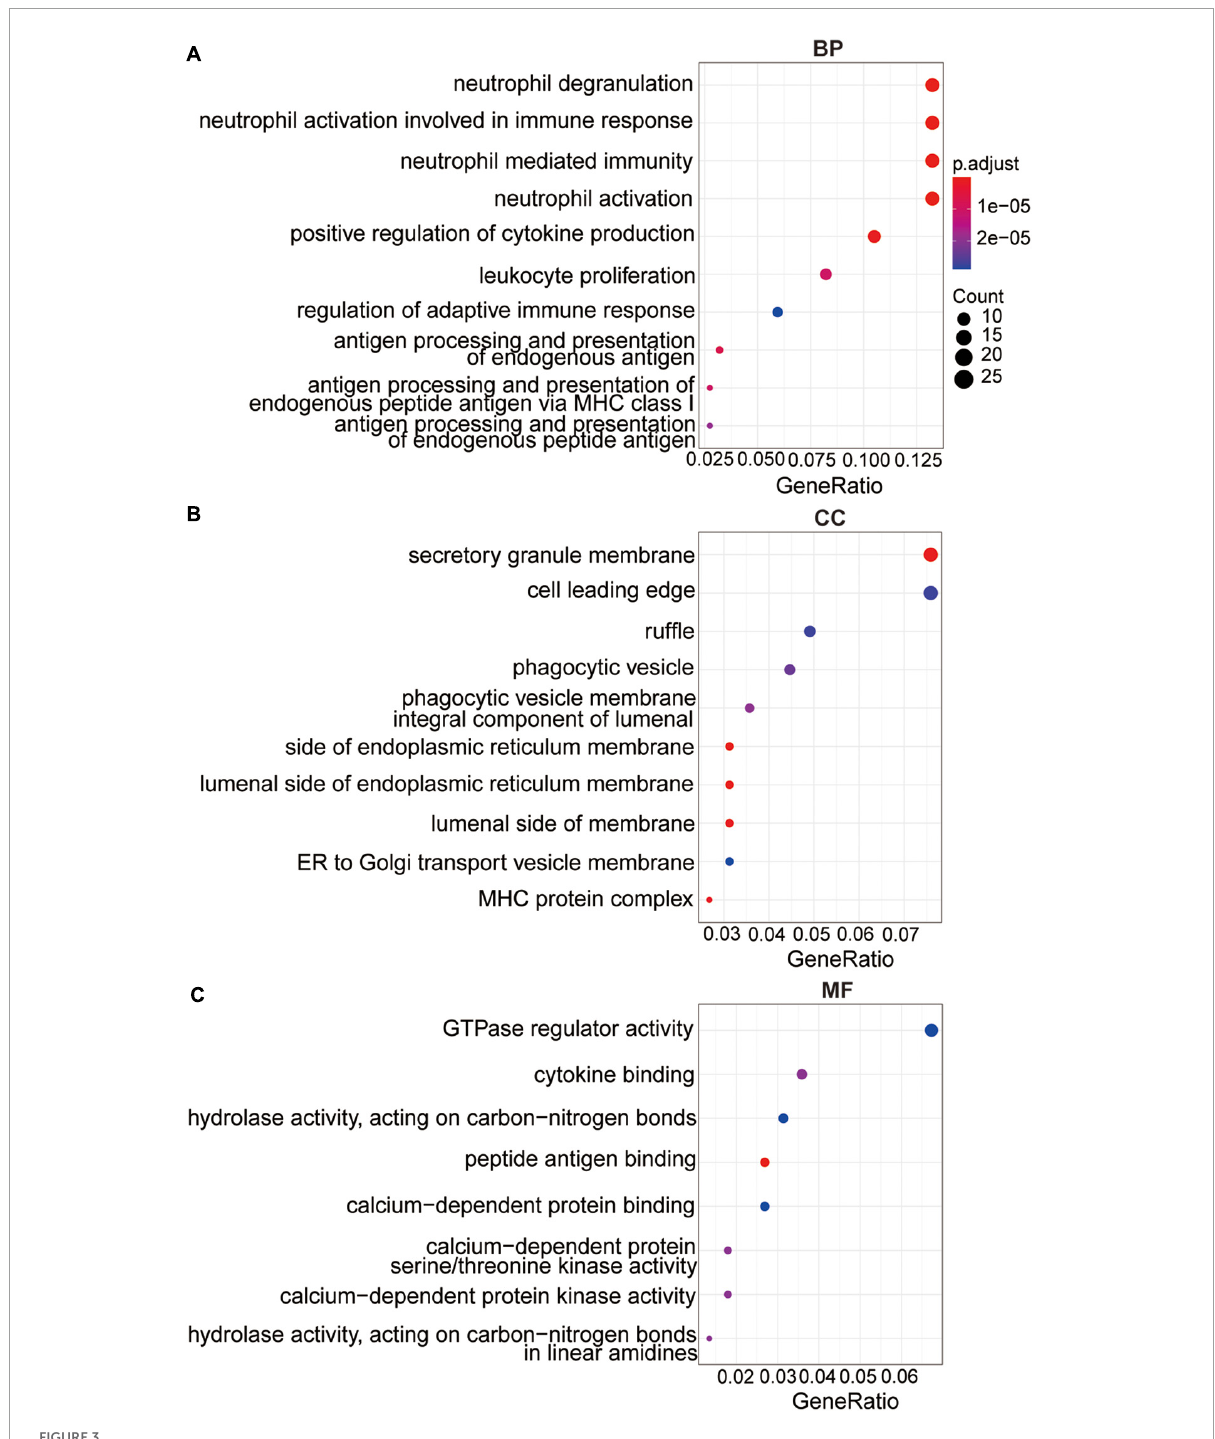
FIGURE3 The functional analysis of the methylation-driven genes. (A) Top 10 of biological process enrichment. (B) Top 10 of cellular component enrichment. (C) Top 10 of molecular function enrichment.